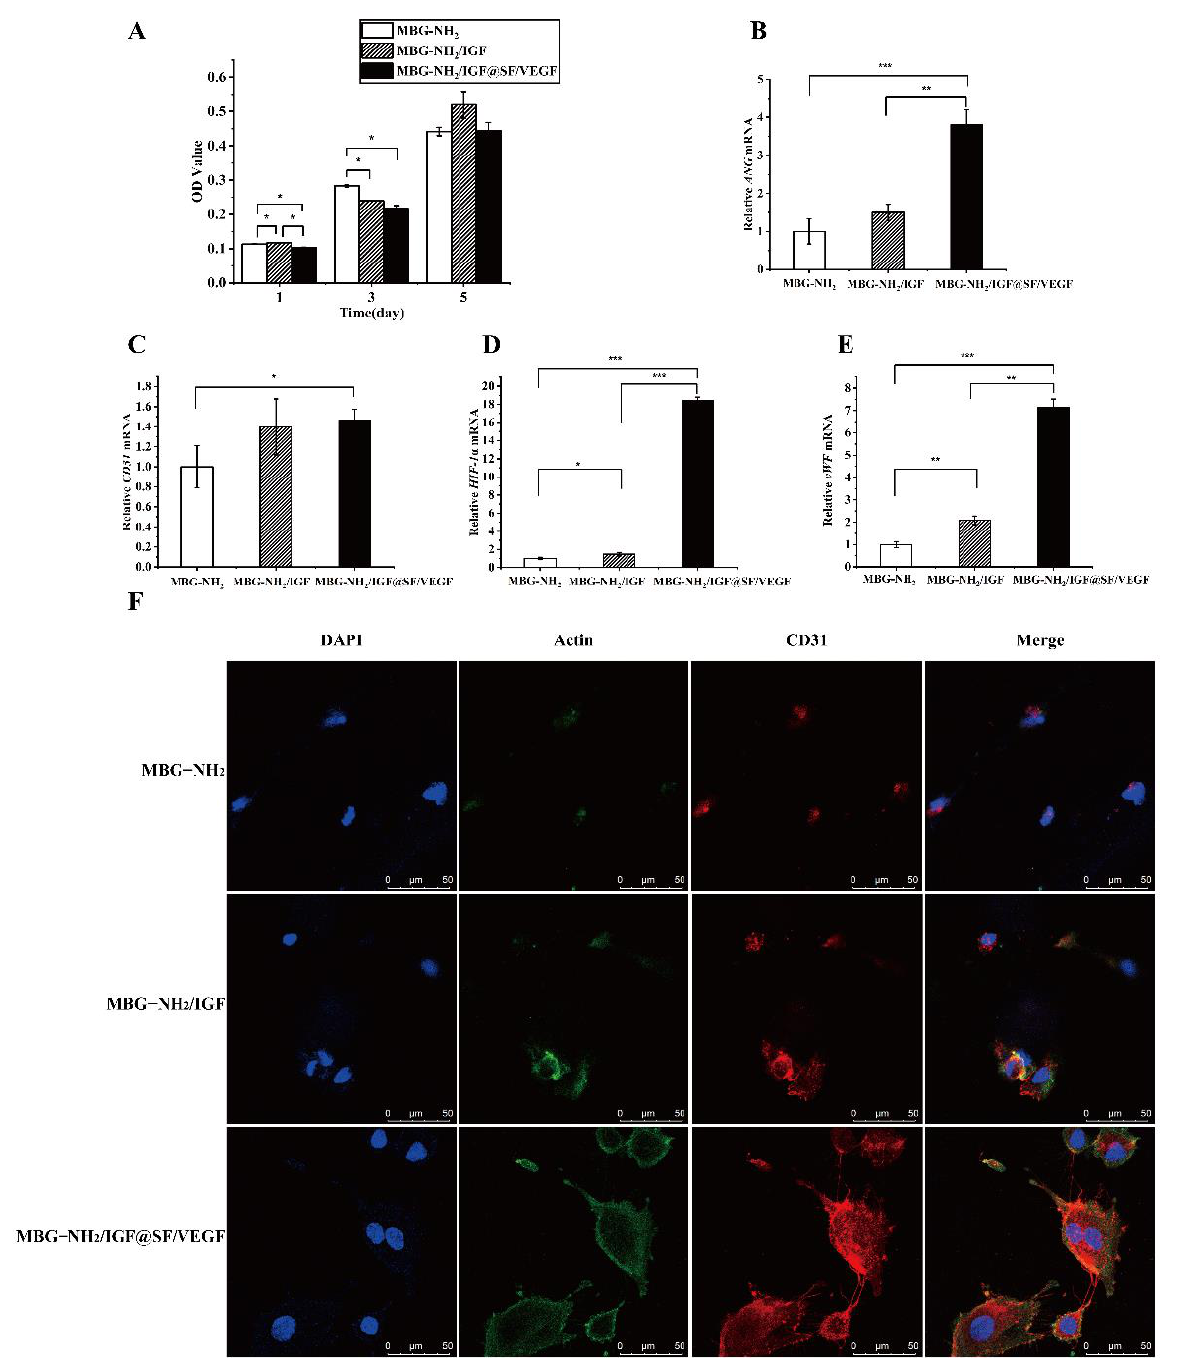
Figure 4. Angiogenic effect of HUVECs cultured on MBG-NH 2 , MBG-NH 2 /IGF, and MBG- NH 2 /IGF@SF/VEGF scaffolds in vitro . ( A ) Proliferation of HUVECs cultured on the scaffolds for 1, 3 and 5 days. ( B – E ) Angiogenic mRNA levels of HUVECs cultured on the scaffolds for 7 days. ANG ( B ), CD31 ( C ), HIF-1 α ( D ) and vWF ( E ). ( F ) CD31 expression level of HUVECs cultured on the scaffolds for 7 days according to immunofluorescence, with Actin as a loading control, stained with FITC. CD31 was stained with Alexa Fluor 594, and nuclei (blue) were stained with DAPI. Scale bars: 50 µ m. Experimental data were analyzed as indicated and reported as mean ± SE. (* p < 0.05; ** p < 0.01; *** p < 0.001).